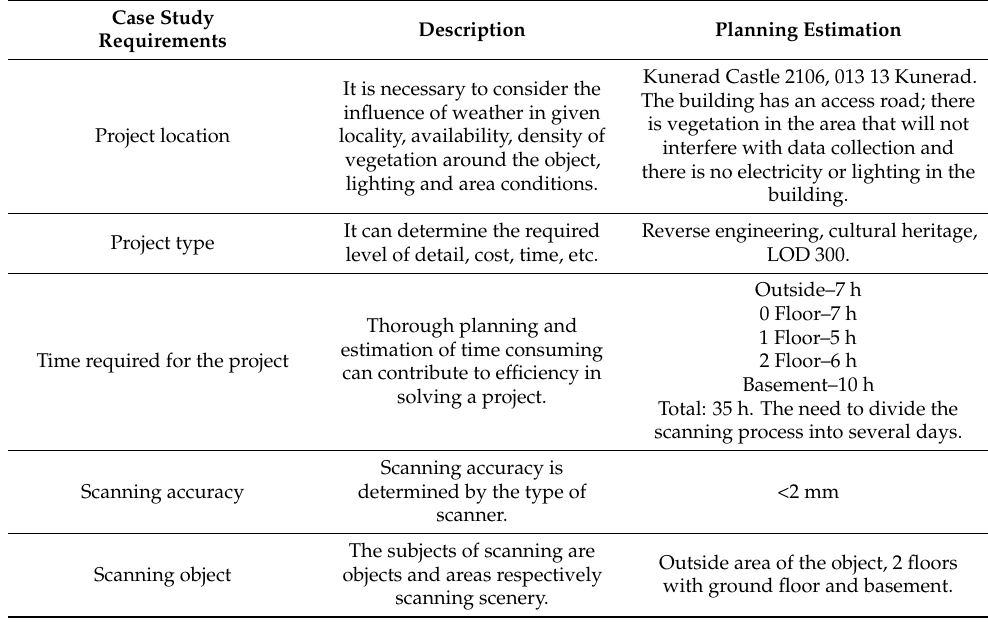
Table 1. Requirements for the implementation of the case study and the planned estimate.